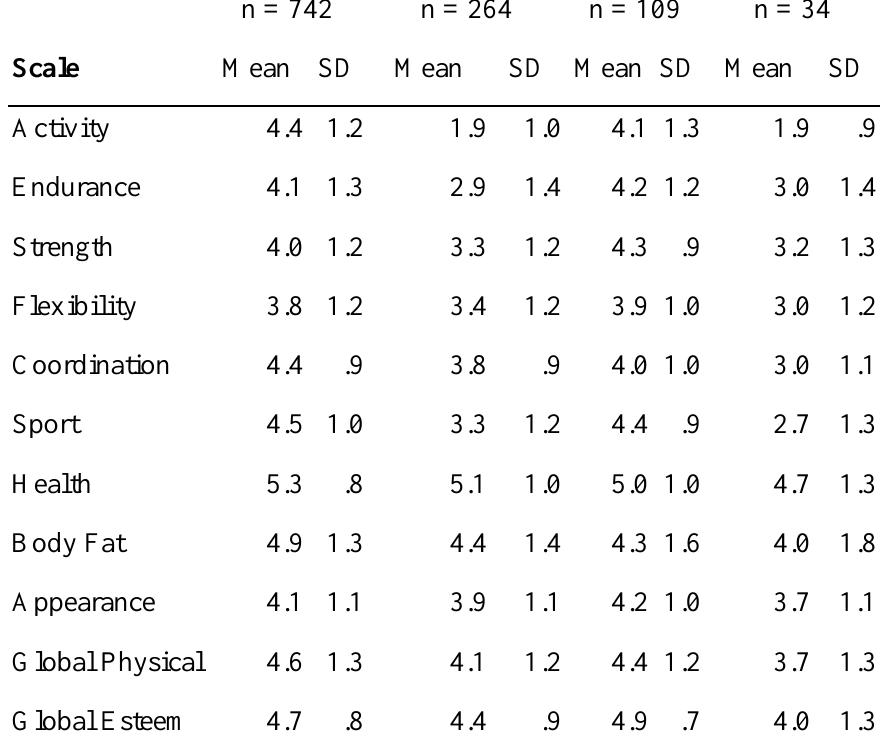
Table 2 Descriptive Statistics for PSDQ Scales in the four